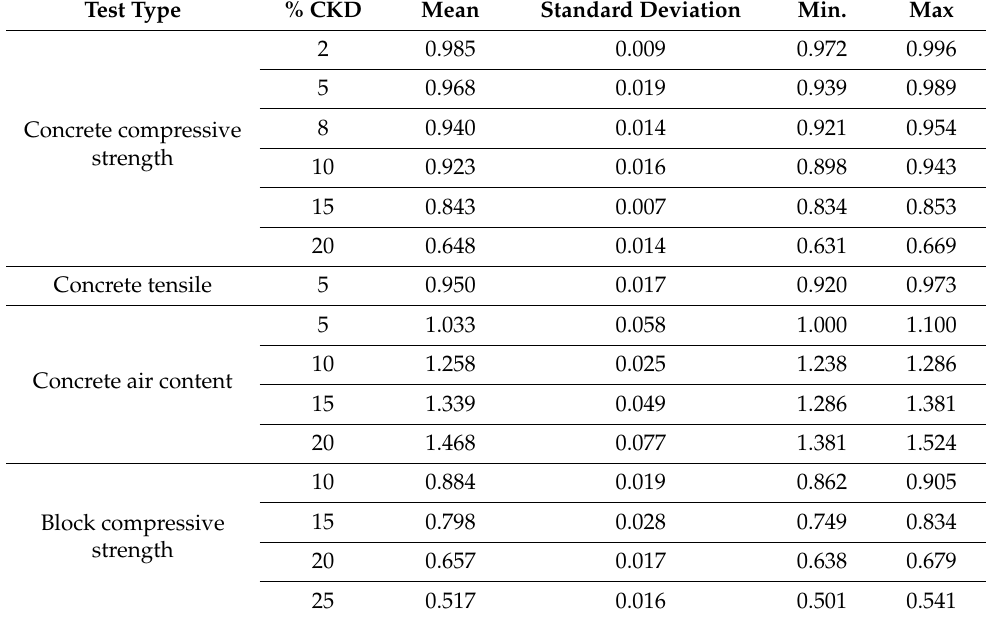
Table 8. Assessment of various test